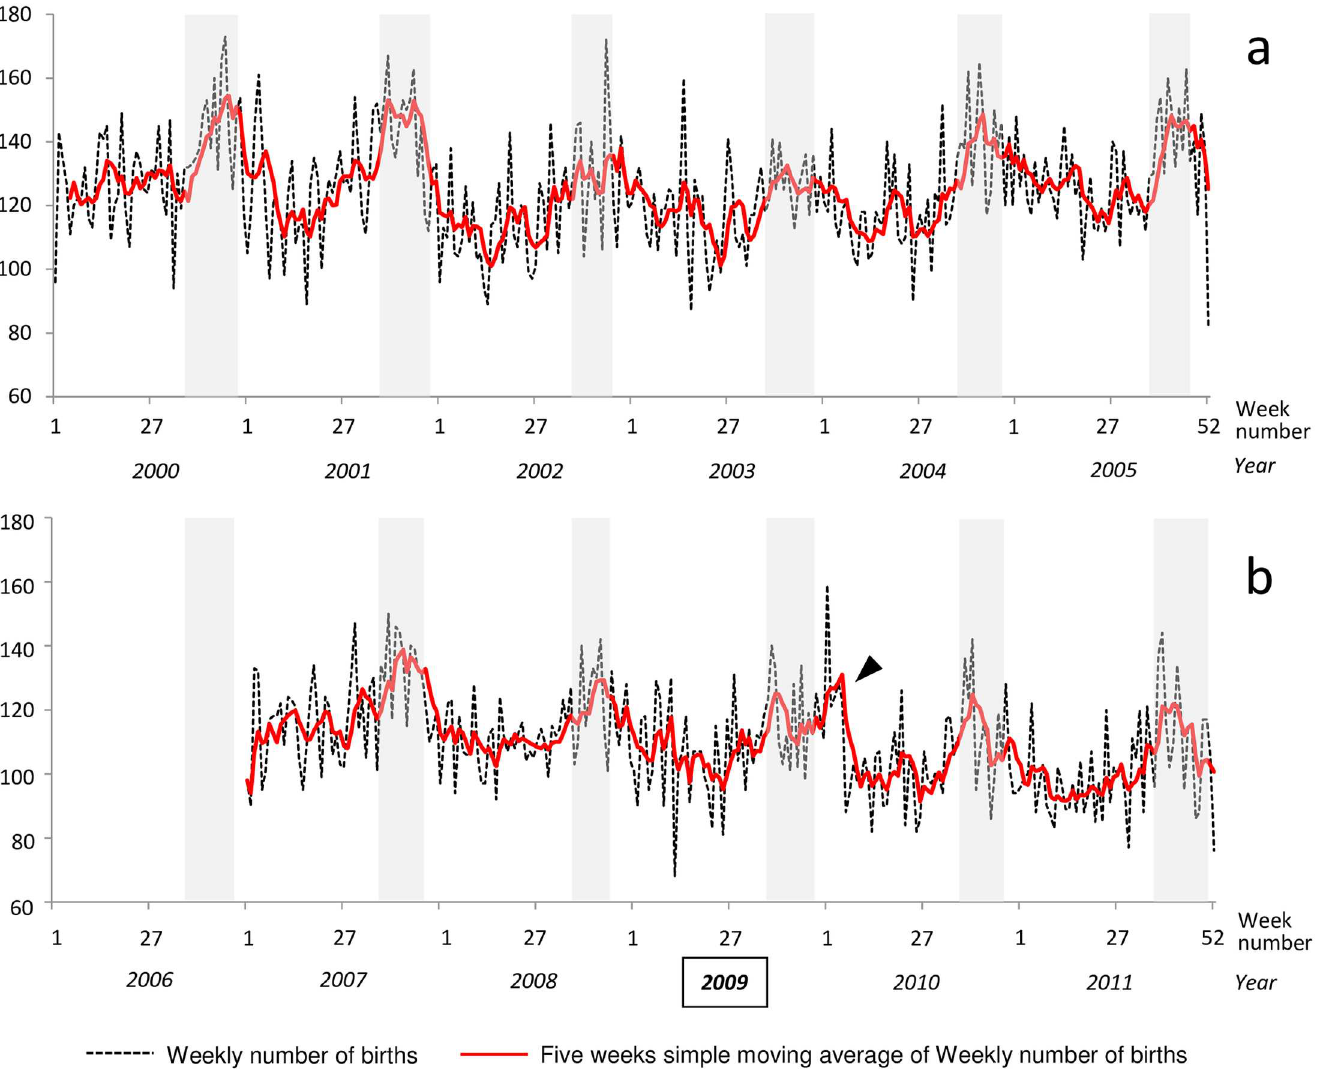
Fig 1. Weekly number of births in Guadeloupe (French West Indies) from January 1 2000 through December31, 2011. a: January 1 2000to December 31, 2005. b: January1 2007 to December 31,